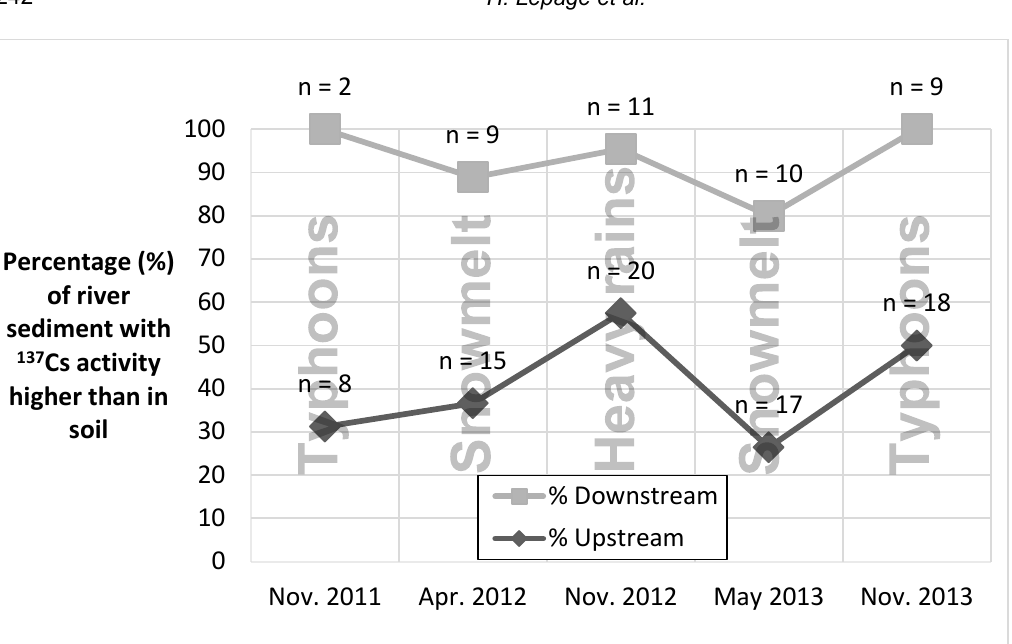
Fig. 5 Evolution of the percentage of sampling sites where radiocaesium activities measured in sediment drape deposits were higher than on nearby soils between November 2011 and November 2013. n stands for number of